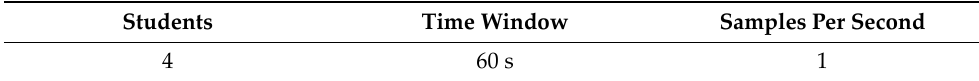
Table 1. Scenario 1 settings for